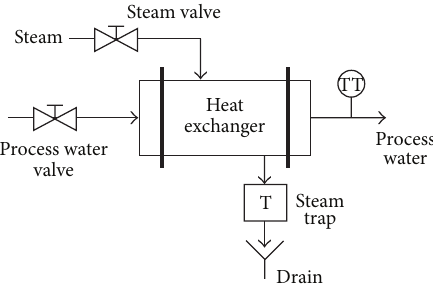
Figure 1: Functional view of two-pass shell and tube heat exchanger [11].